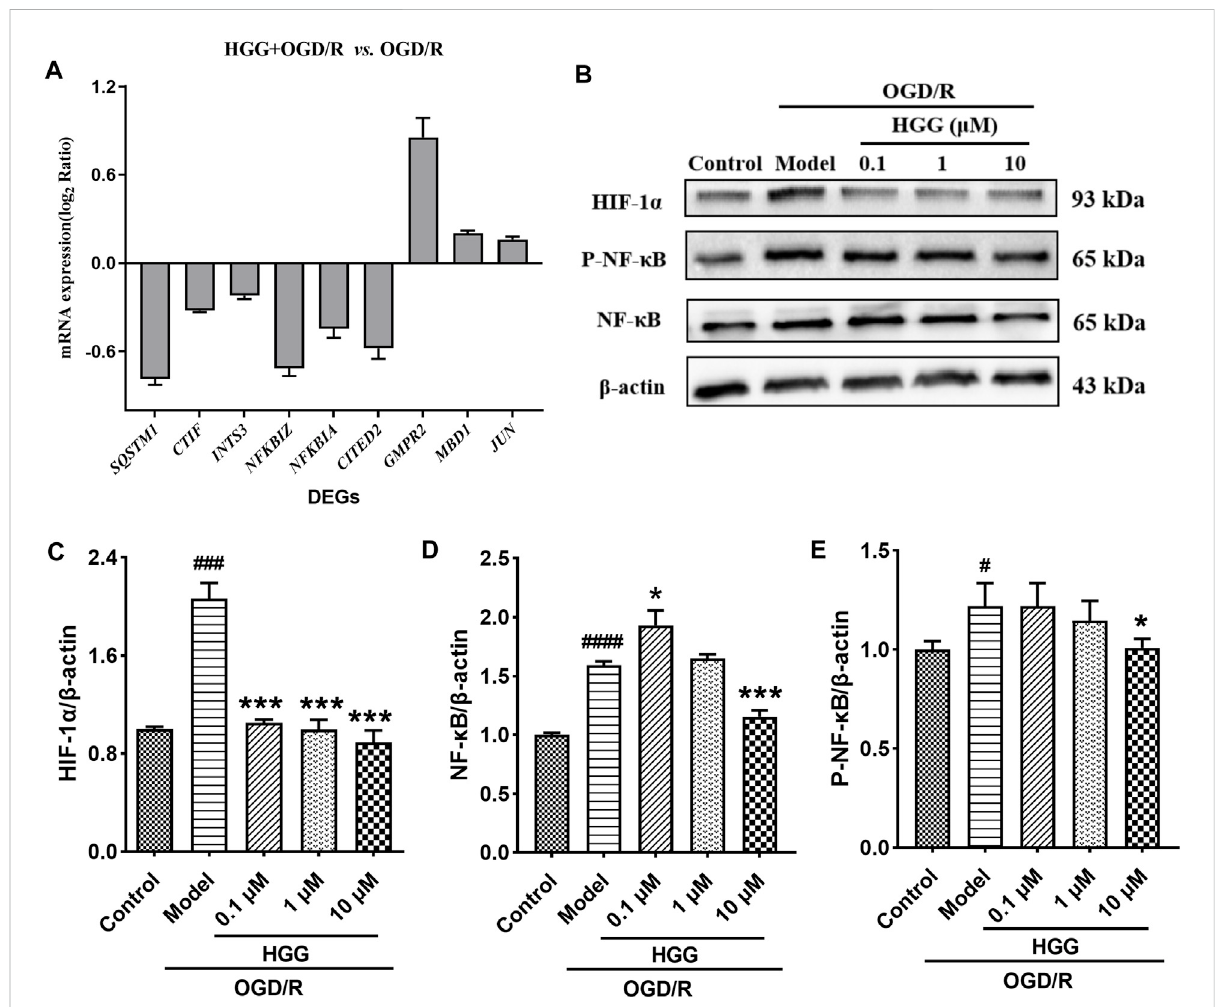
FIGURE 6 HGGprotectsHUVECsagainst OGD/R-inducedapoptosis via HIF-1 α /NF- κ Bpathway. (A) ThemRNAexpressionlevelsofnineDEGsafter OGD/ Rincubation; (B) TheproteinexpressionlevelsofHIF-1 α ,NF- κ B,andp-NF- κ BinWesternblotexperimentforHUVECsunderOGD/Randtreatedwith HGG at 0.1, 1, and 10 μ M; (C – E) Semi-quanti fi cation of protein expression by Image J analysis. All data were presented as means ± SD ( n = 3). # p <